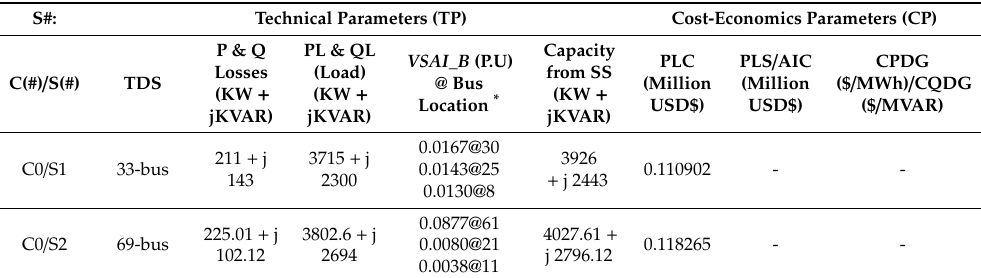
Figure 5. Base case without DG (Steps 1–4) ( a ) VSAI_B projection without DG in 69-bus MDS; ( b ) Achieved ( V_C ) and calculated ( V_C ) Voltage profiles without DGs in 69-bus MDS. Table 4. Overview of performance in base case without DG as Case 0 (33-Bus and 69-Bus).